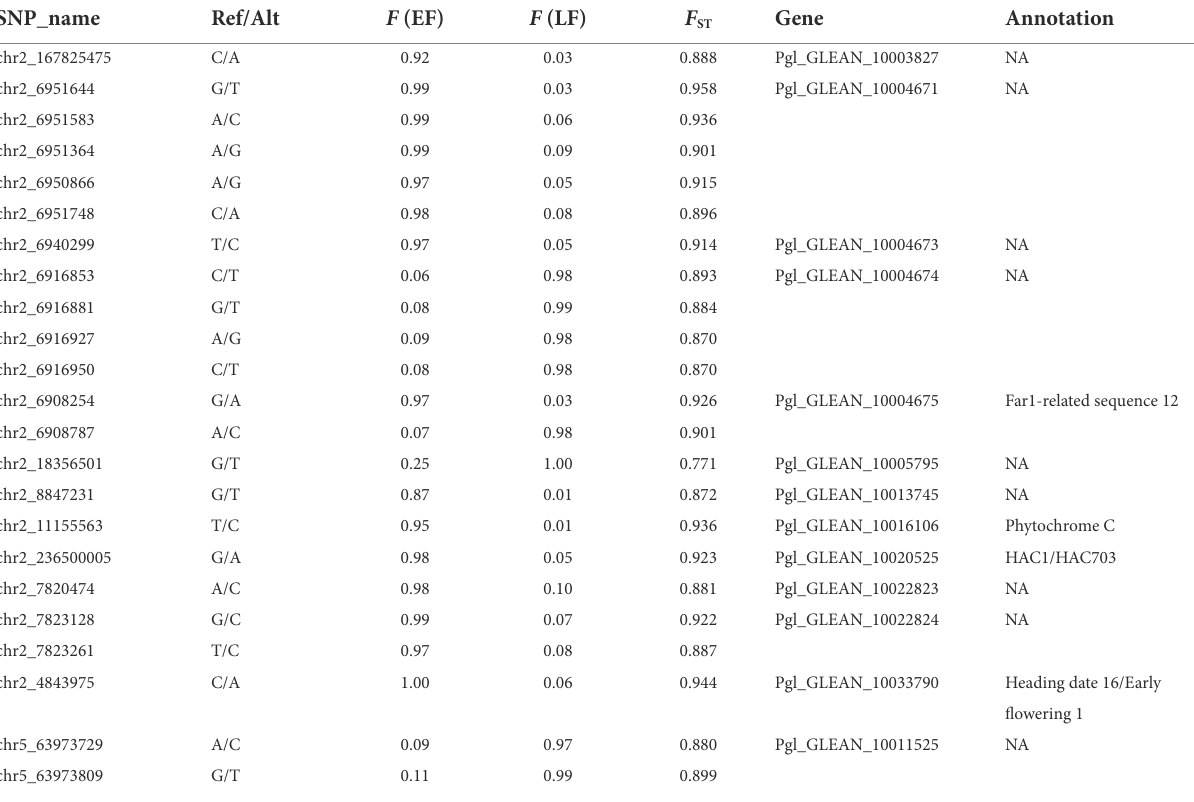
TABLE 2 List of the 23 SNPs detected by both PCAdapt and BayeScan methods. Reference and alternate alleles are provided.